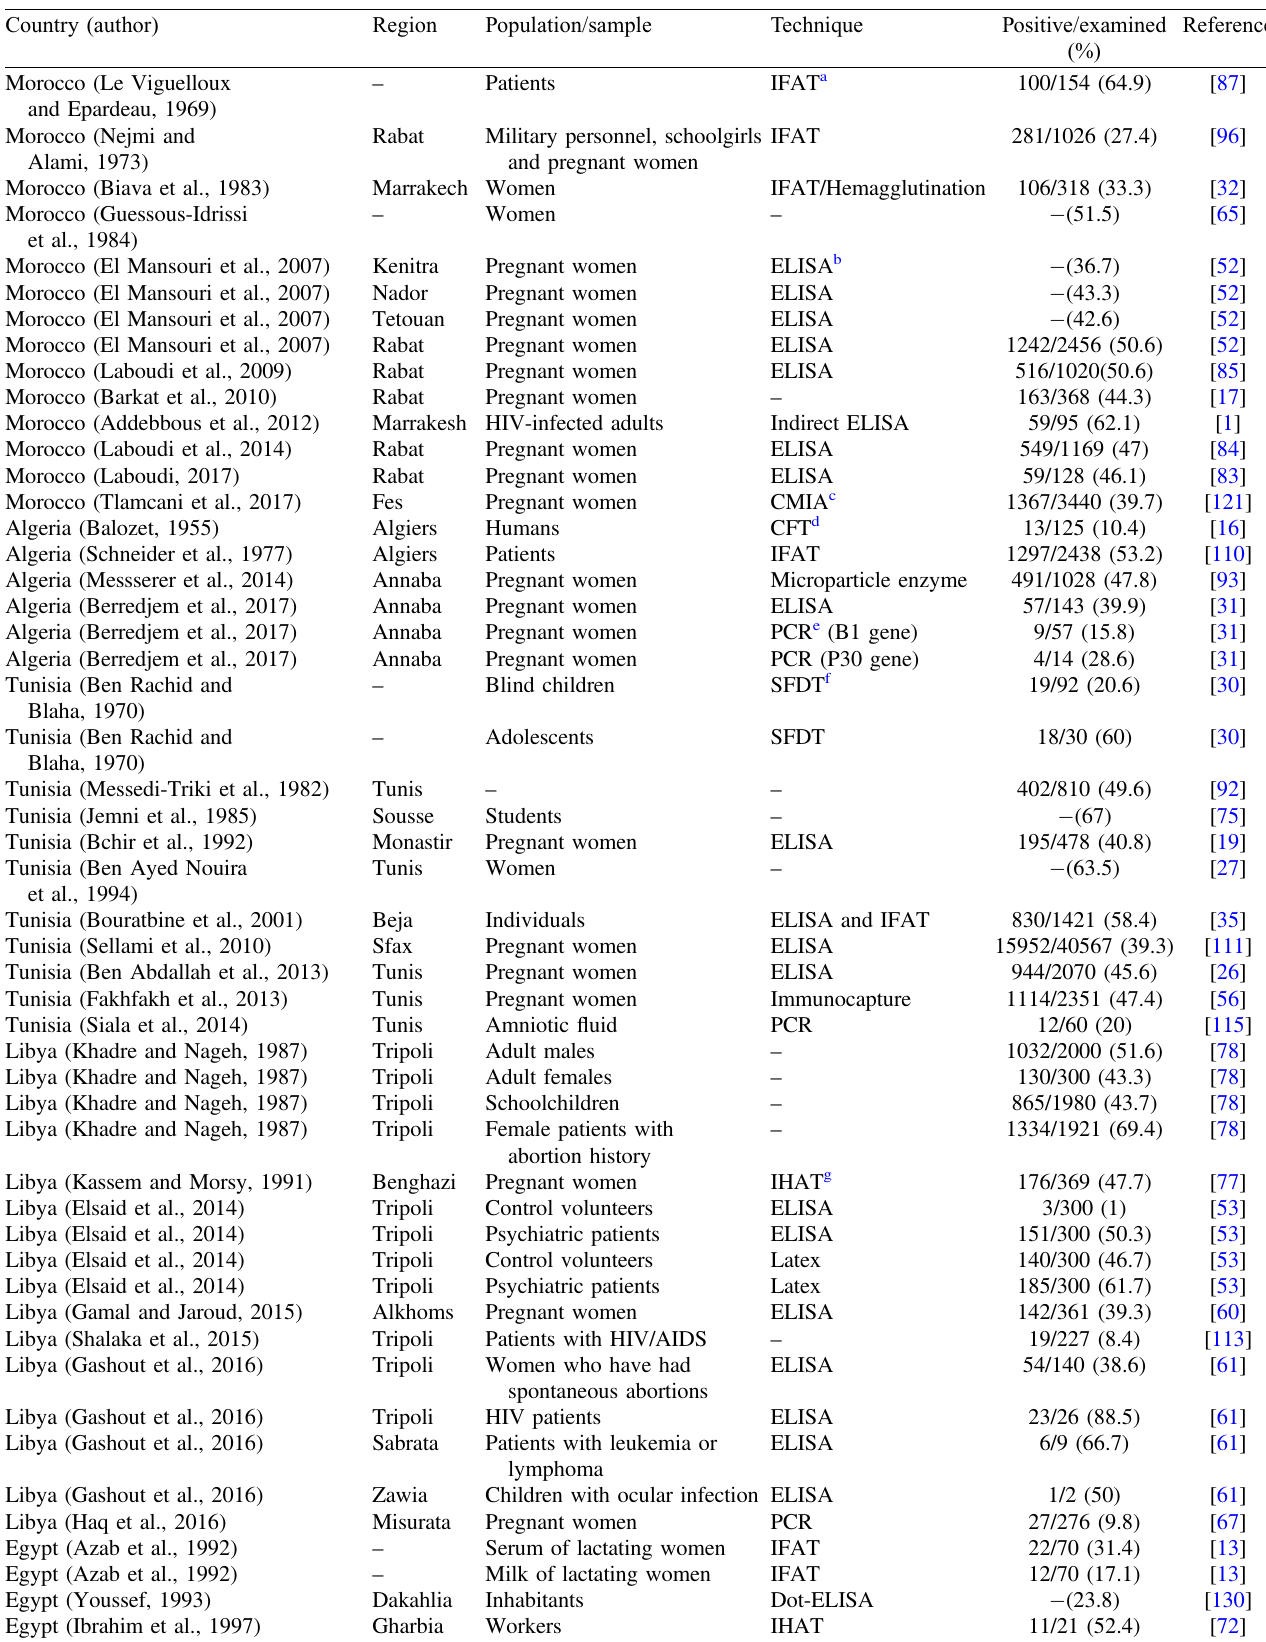
Table 5. Human toxoplasmosis prevalence in North African countries. Country